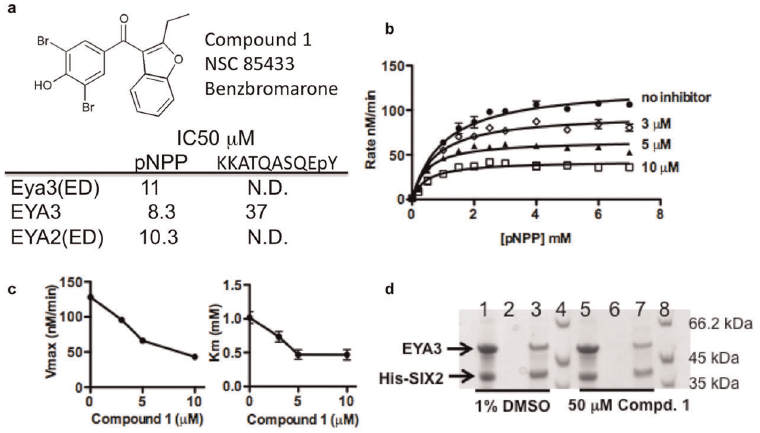
Figure 2. EYA inhibitor Benzbromarone, compound 1. ( a ) Compound 1 was identified from a screen of the NCI Diversity Set II library. IC50 values for compound 1 were measured for Eya3(ED), human EYA3 and human EYA2(ED) using as substrates the phosphotyrosine mimic pNPP and a phosphopeptide representing the last 10 amino acids of H2AX, a known EYA substrate. ( b ) Substrate titration shows that compound 1 is an uncompetitive inhibitor of EYA3(ED). Increasing concentration of substrate does not overcome inhibition. Each point represents the mean and standard deviation of two independent readings. ( c ) Plots of Vmax and Km as a function of inhibitor concentration show that both values decrease with increased inhibitor concentration. Values in (c) were derived from nonlinear regression analyses of curves in (b) using PRISM (GraphPad Software). ( d ) Compound 1 does not affect the interaction between EYA3 and SIX2. Recombinant purified EYA3 and His-SIX2 were mixed and treated with either the vehicle control (1% DMSO) (lane 1) or 50 m M compound 1 (lane 5) for 15 minutes at room temperature. The mixture was loaded on a Ni-NTA column. Beads were washed with 3 column volumes of load buffer (last washes, lanes 2 and 6). Proteins retained on the beads are shown in lanes 3 and 7. Lanes 4 and 8 are molecular weight